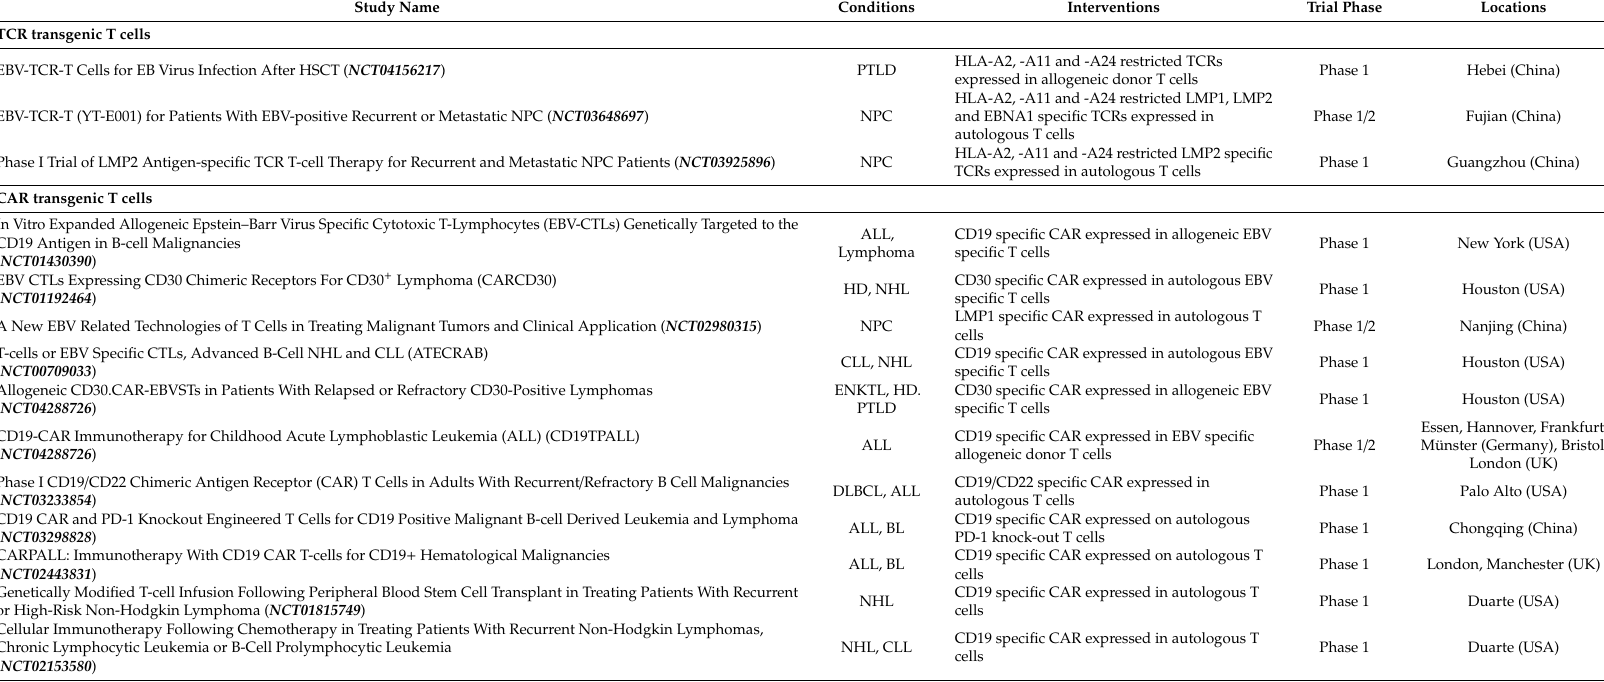
Table 1. Selection of clinical trials with transgenic T cell treatments targeting EBV associated malignancies from ClinicalTrials.gov (www.clinicaltrials.gov), that clearly name EBV positive tumors as one of their indications for